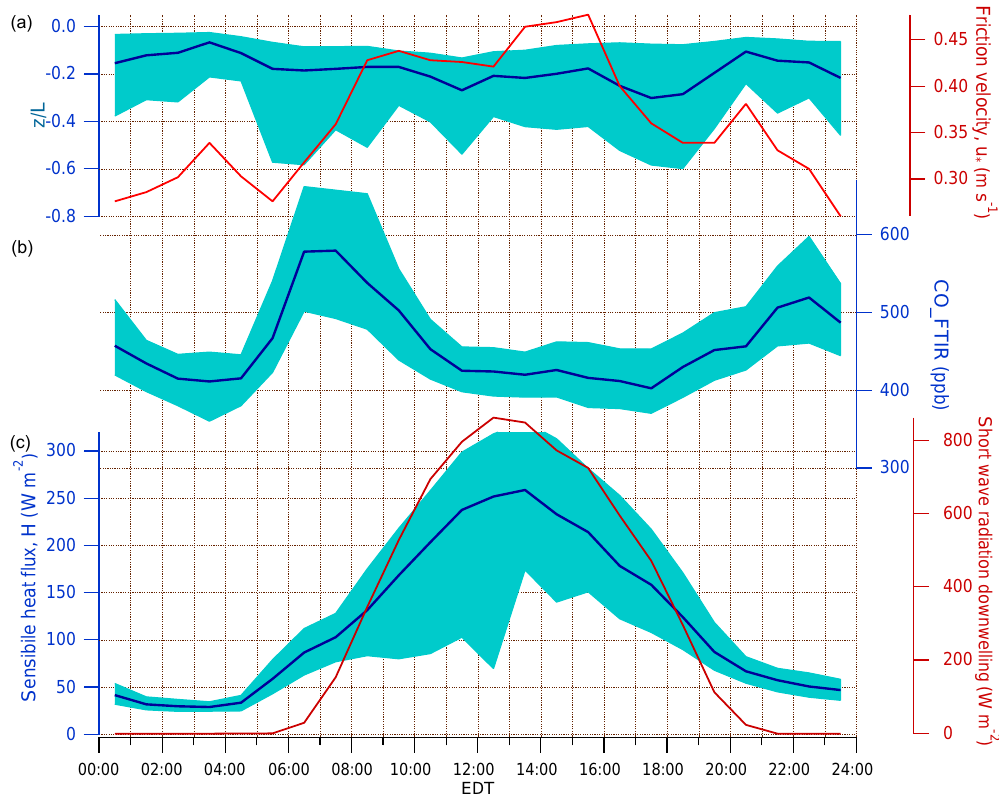
Figure 2. Average diurnal cycles (1-hour averages) of z/L and u ∗ (a) , CO mixing ratio retrieved from the FTIR spectrometer (b) , and sensible heat flux H and downwelling shortwave radiation (c) for 16–31 July 2015. Lines represent the medians, and the shaded regions are the interquartile ranges for z/L , CO, and H